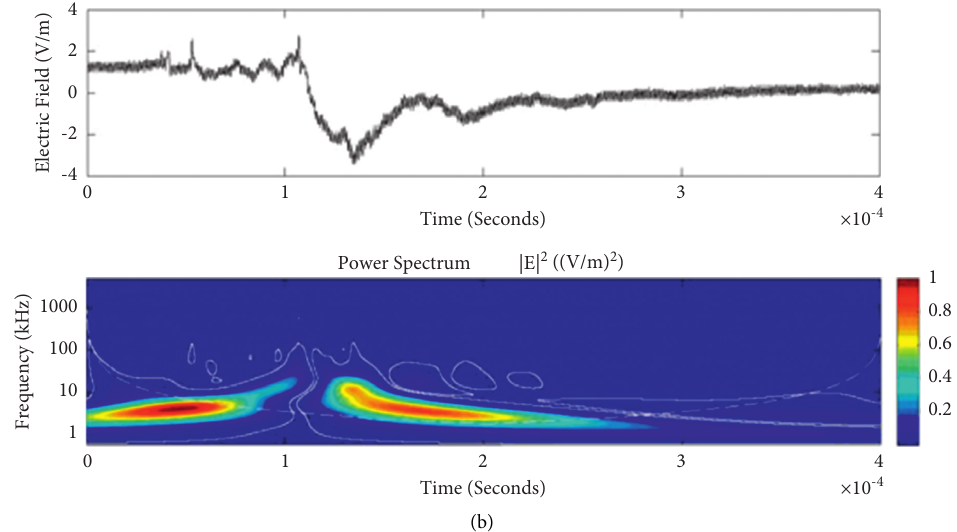
Figure 11: Example of the wavelet power spectrum of the first event (a) and second event (b) of the unusual lightning signal which is recorded as a flash number 20150416-0029 in Kathmandu, Nepal. The window size of the event is 400 μ